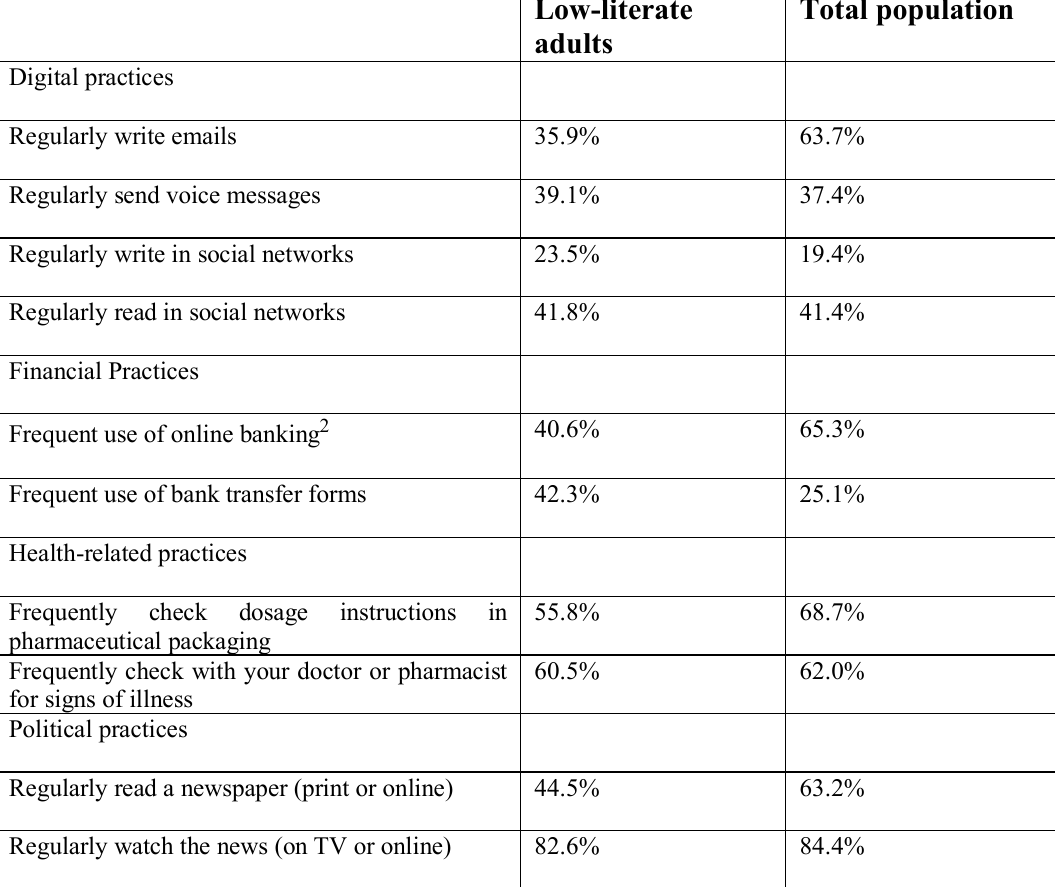
Table10: Proportion of adults performing domain-specific practices at least once a week, low-literate adults compared to the total